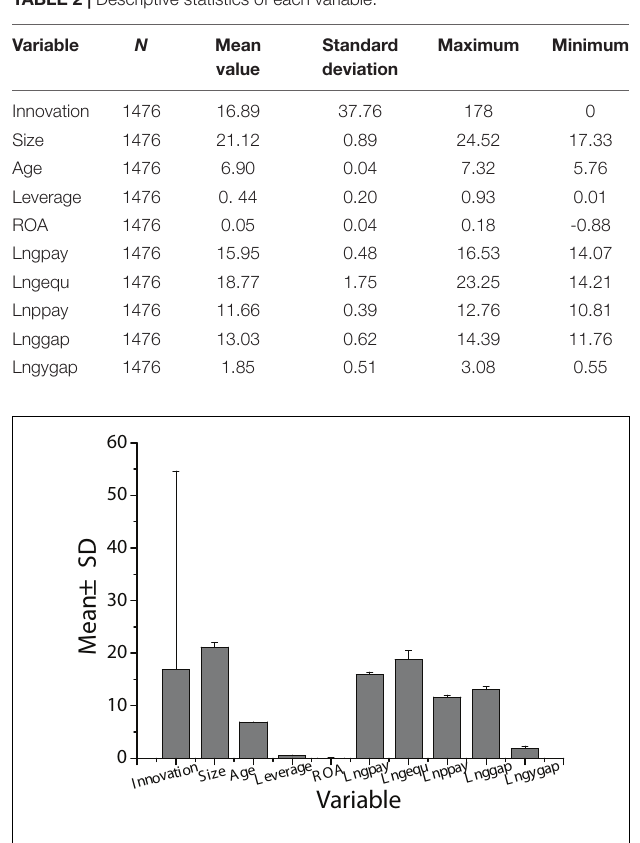
FIGURE 2 | Descriptive statistical means of each